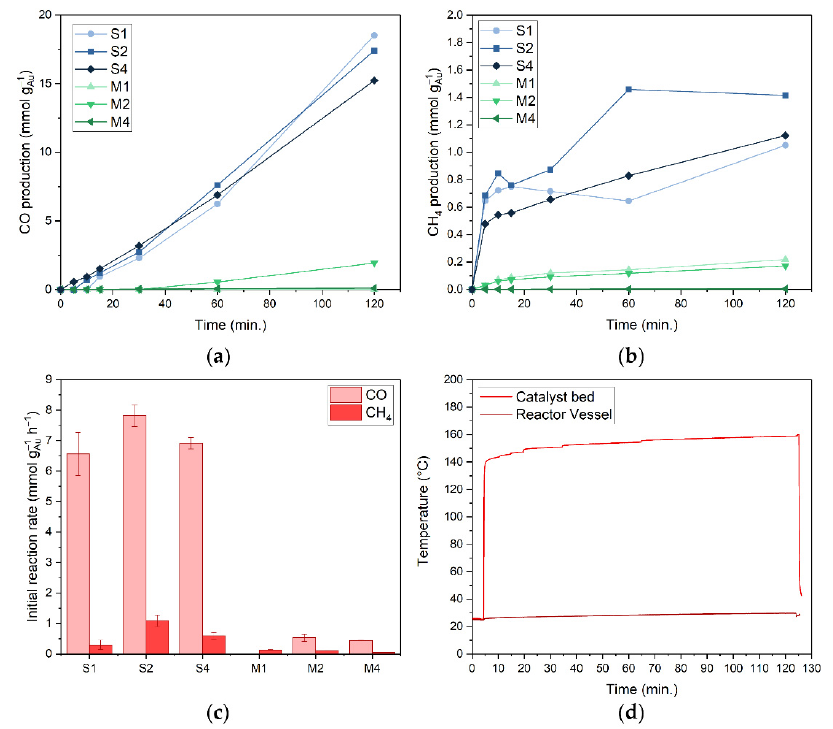
Figure 2. ( a ) CO production of S1–4 and M1–4 catalysts under illumination; ( b ) CH 4 production of S1–4 and M1–4 catalysts under illumination; ( c ) initial reaction rates of S1–4 and M1–4 catalysts for both CH 4 and CO production under illumination. Error bars represent a 98% confidence interval; ( d ) catalyst bed and reactor vessel temperature of S2 catalyst during reaction. Connecting lines are a guide to the eye. Reaction conditions: mixture of CO 2 :H 2 :N 2 (2:2:1) at 3.5 bar pressure, 200 mg Au/TiO 2 catalyst, 13.9 sun irradiation from solar simulator (AM1.5); 1 sun = 1 kW m − 2 .